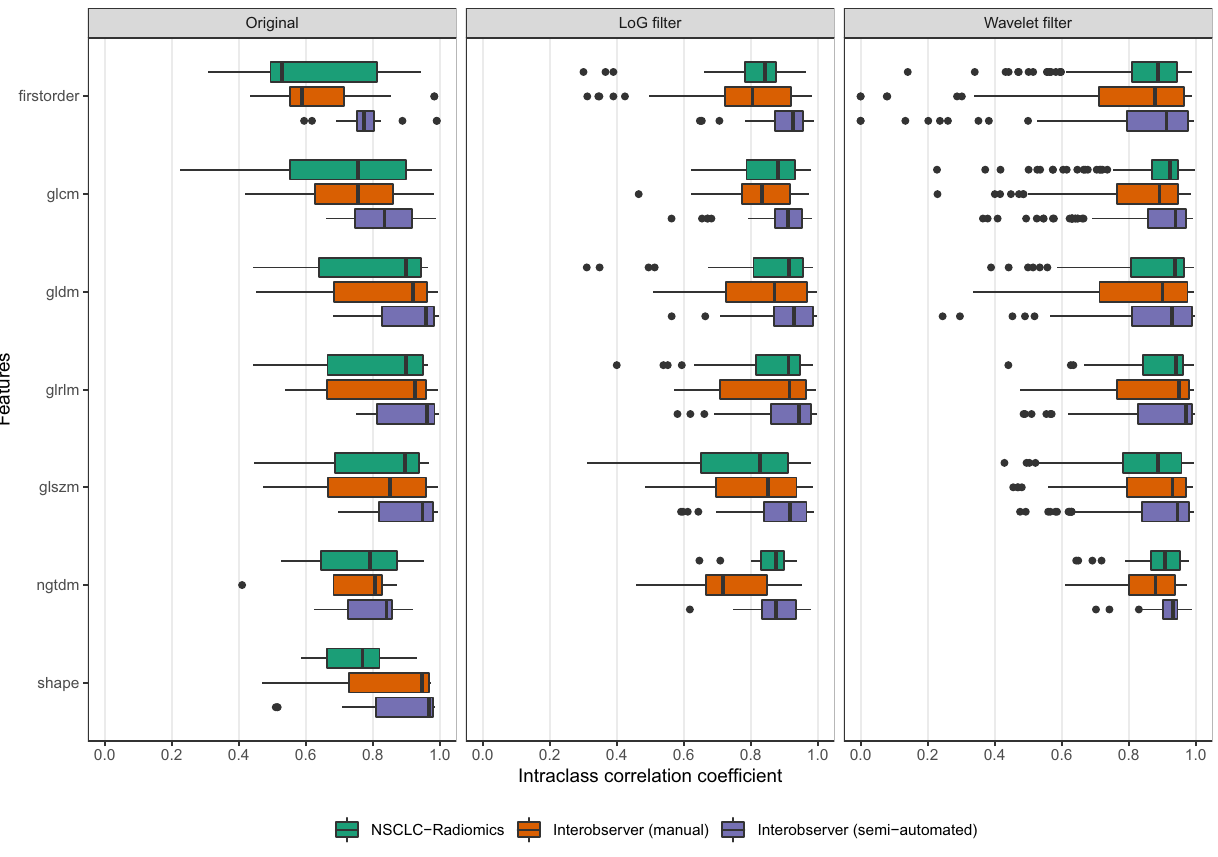
Figure 3. Intraclass correlation coefficients (ICC) by feature type. This figure separately considers the ICC values of radiomics features by different classes of features, as well as with the addition of Laplacian of Gaussian (LoG) and wavelet filters for the ‘NSCLC-Radiomics’, ‘Interobserver (manual)’ and ‘Interobserver (semi- automated)’ sets of contours.